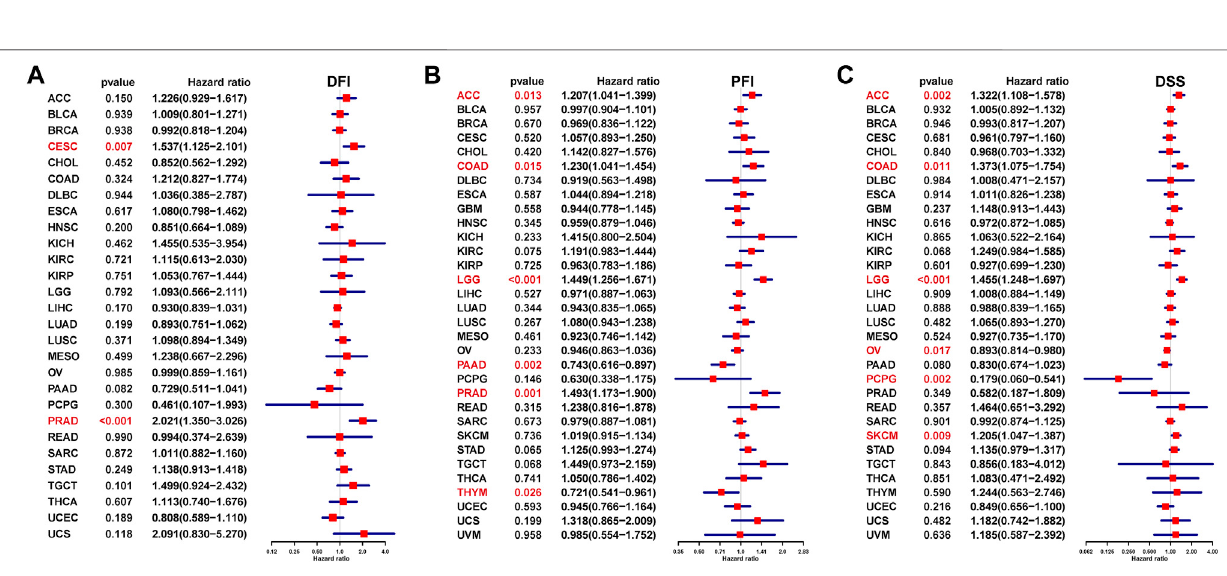
Frontiers in Cell and Developmental Biology |